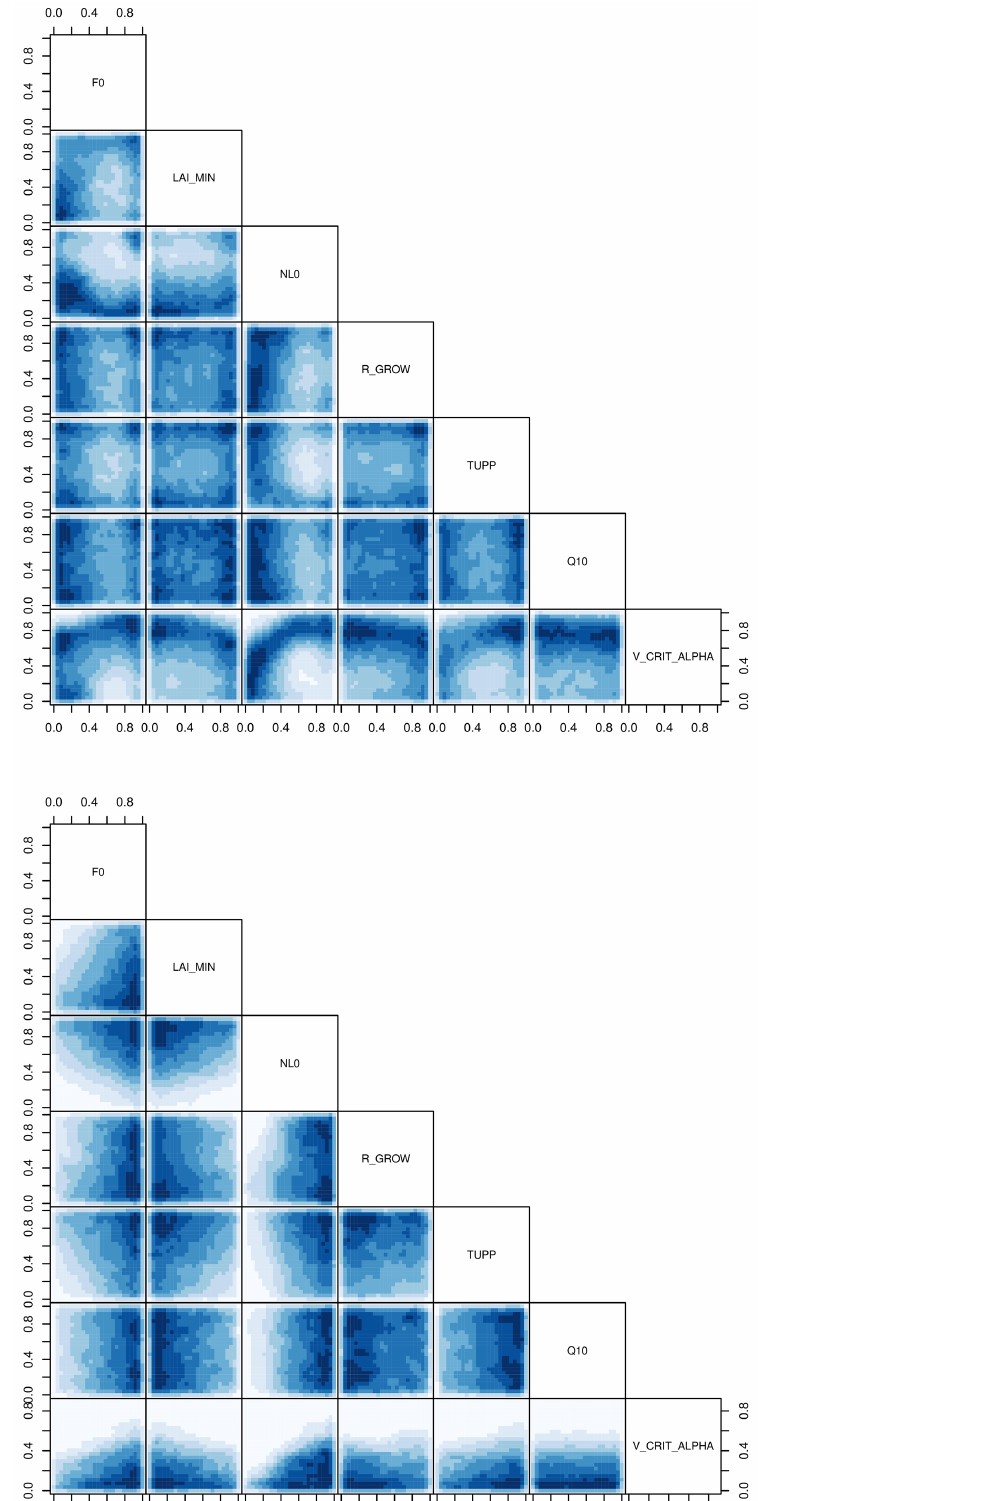
Figure 10. Marginal density of input parameter sets consistent with a very low “tolerance to error”, as well as perfect observations, for the North American, South East Asian, and Central African forests combined (top panel) and the Amazon (bottom panel). Dark blue indicates those regions which have the highest concentration of NROY candidates and which are therefore most compatible with the